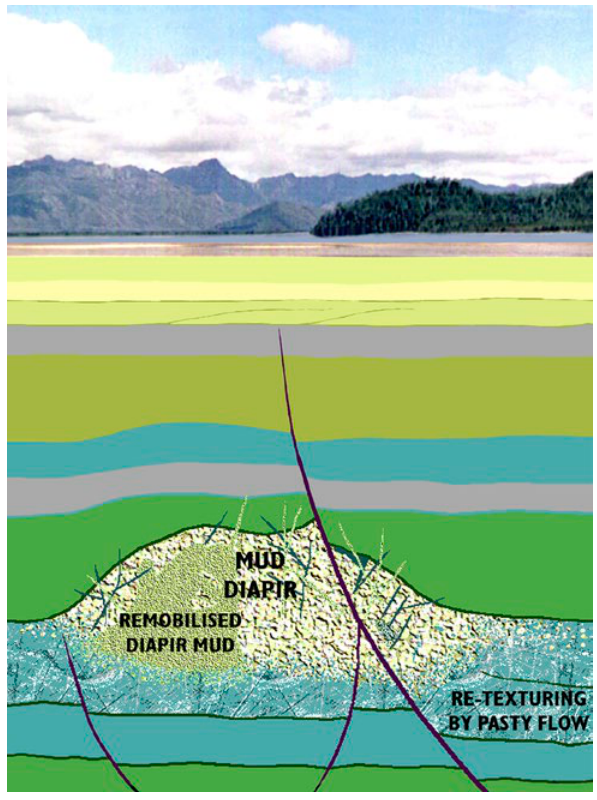
Figure 44. Sediment particles are hydrated metal silicates such as clays. These are mainly potassium or Na-Ca alumino-silicates that hydrolyse further in